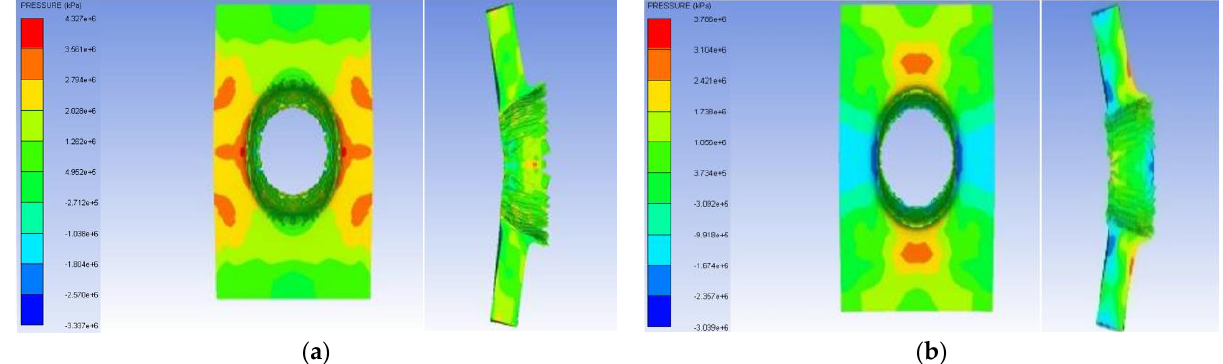
Figure 13. Pressure cloud diagrams of different head metal blocks colliding with RHA steel target at 0.1 ms, ( a ) 0 mm, and ( b ) 10 mm.